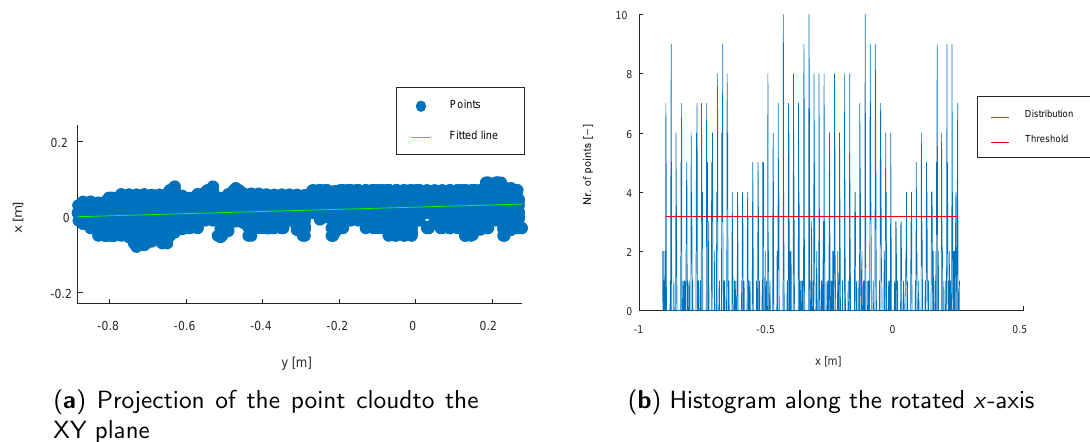
Figure 4. Processing the point